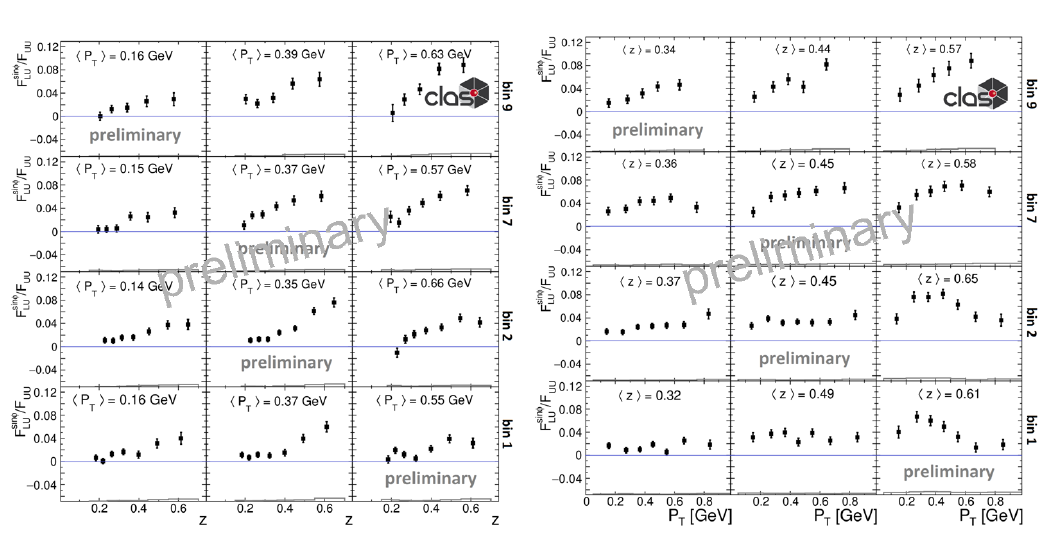
Figure 3: z dependence (left) and P / z bins (left to right) and for different Q 2 - x increasing P T uncertainty is given by the histogram above the horizontal